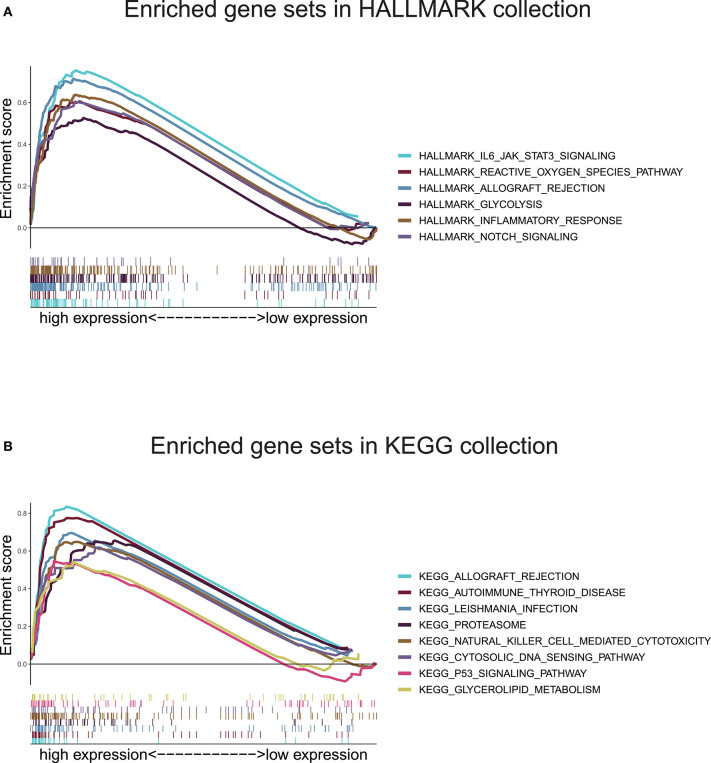
Gene set enrichment analysis based on the ten-gene signature. (A) Enriched gene sets annotated by the HALLMARK collection between the high and low-risk groups in the training cohort. (B) Enriched gene sets annotated by the KEGG collection between the high and low-risk groups in the training cohort. Gene sets with |NES |> 1, NOM p < 0.05, and FDR q < 0.25 were considered significant.